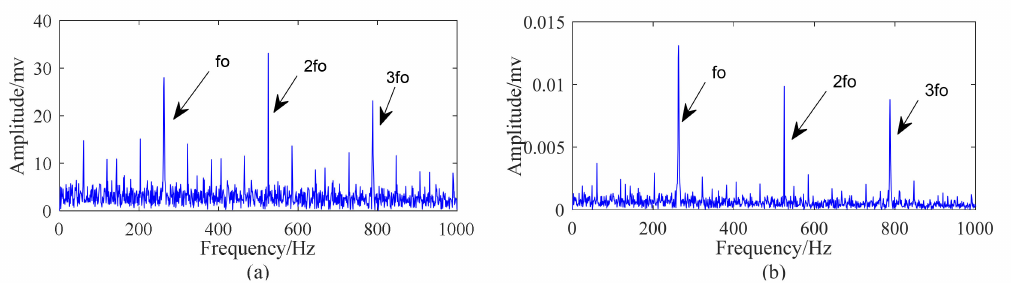
Figure 28. The diagnosis result obtained by IMF3 of the collected signal of the bearing with 3 mm outer race fault: ( a ) the squared envelope spectrum of IMF3; ( b ) the teager energy spectrum of IMF3.